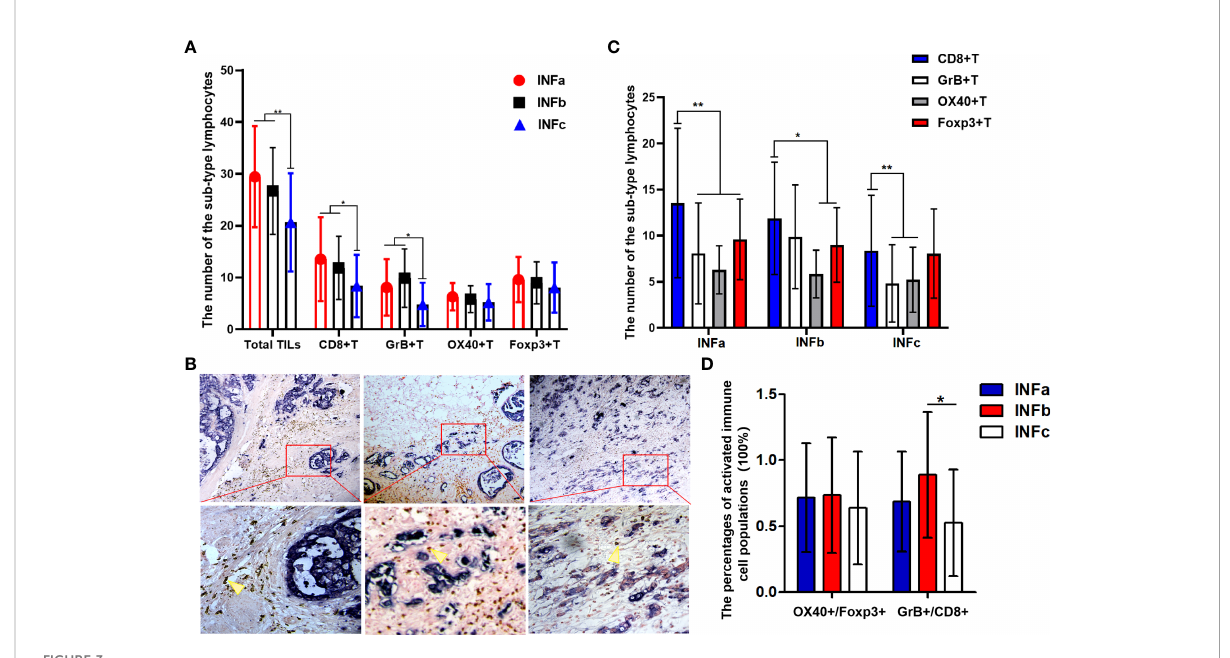
FIGURE 3 (A,C) Graphsshowingthefoursub-typesoftumor-in fi ltratinglymphocytedistributionincancertissueswithdifferenttypesoftumorin fi ltrationpattern(INF).The numberoftotalimmunecellin fi ltrateswaslessinINFcthanthatinINFa( P <0.001)orINFb( P =0.001) (A) .ThenumberofCD8+Tcellsoccupiedaquantitatively dominantposition( P =0.001)intheINFacases (C) .Representativedouble-immunohistochemistrystainingforthetumorcells(purple – blue)andCD8+Tcells (brown,yellowarrow)ingastriccancertissuewithdifferenttypesofINF,andthelowerpictures(×400)arethecorrespondingenlargementofthelocalarea(red, rectangular)fortheupperpictures(×100) (B) .TherelativepercentageofactivatedimmunecellpopulationsforCD8+(GrB+/CD8+)issigni fi cantlyhigherinthe INFbgroupcomparedwiththatinINFc( P =0.02) (D)